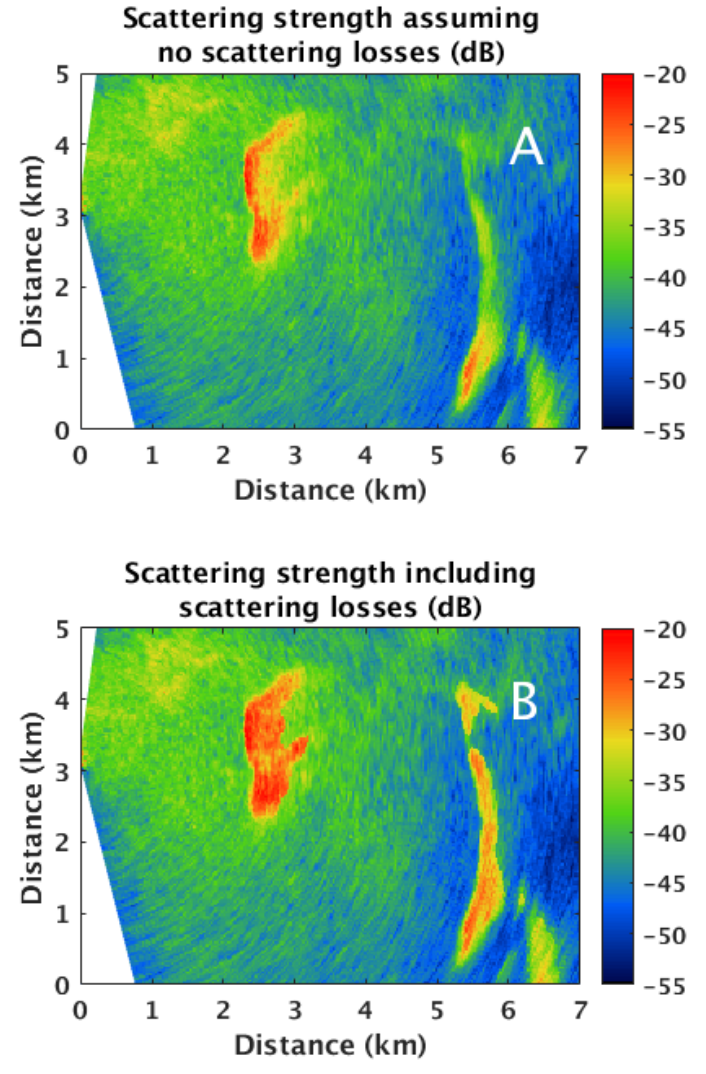
Figure 6. The waveguide attenuation model can be used to account for scattering losses in acoustic backscattering data. Here, scattering strength images of herring shoals are shown from 04:33:19 on 21 February 2014 with ( A ) no scattering losses included and ( B ) scattering losses included. After accounting for scattering losses, the scattering strength of both the occluding shoal (Easting: 2–3 km, Northing: 2–4 km) and the distant shoal (Easting: 5–6 km, Northing: 0–4 km) are comparatively uniform in space and are not biased by the horizontal extent of fish in the propagation path. Scattering losses are calculated using the following parameters: mean shoal depth z 0 = 60 m, shoal height H = 40 m and neutral buoyancy depth z nb = 0